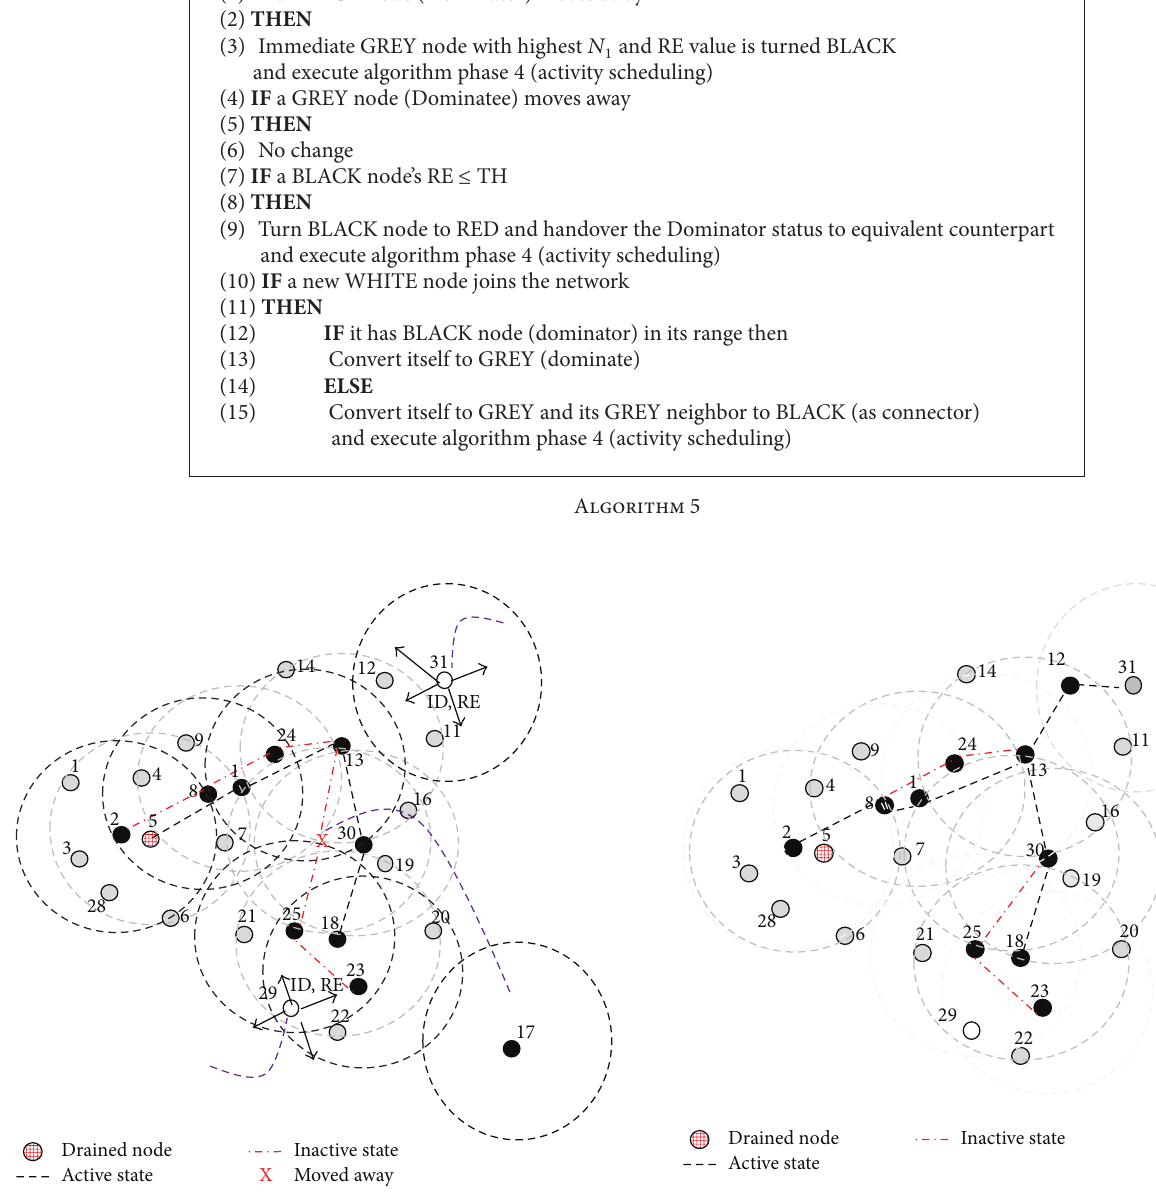
Figure 7: The final repaired CDS with minimal activity